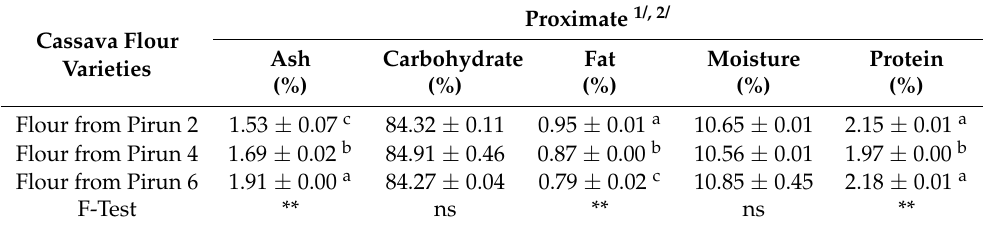
Table 1. Proximate analysis of flour from difference varieties of cassava flour.